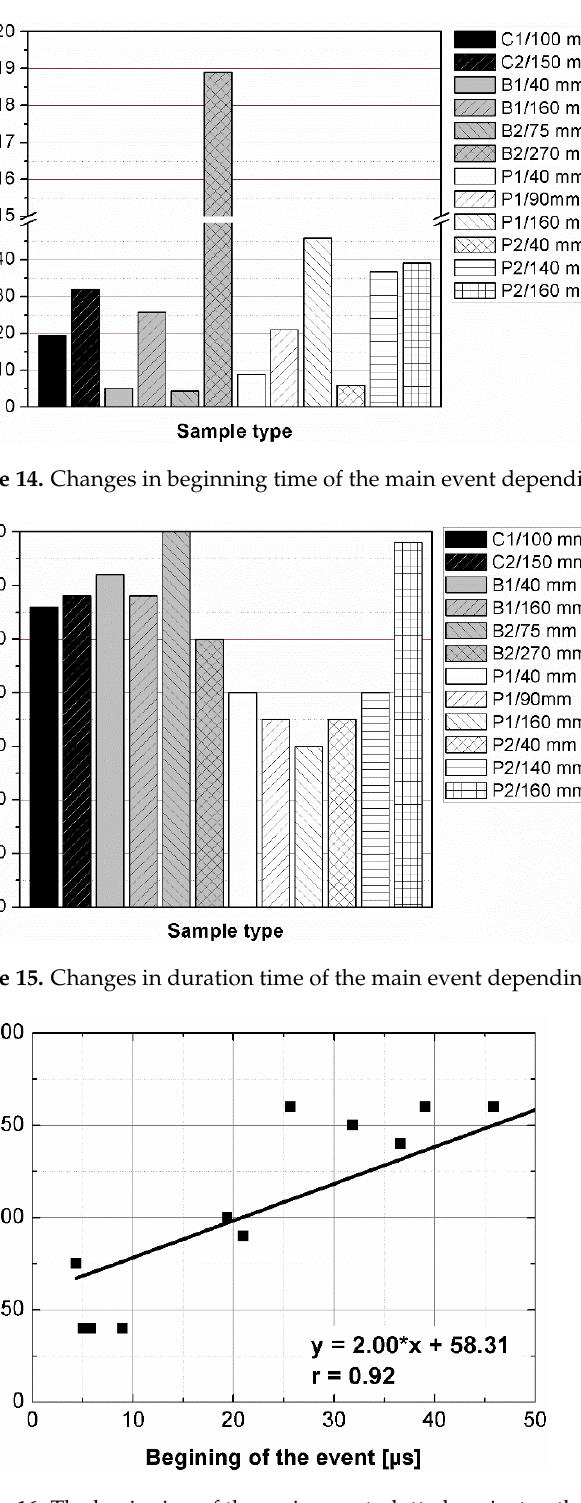
Figure 13. Spectrograms obtained by Fourier synchrosqueezing transform of signals registered after transmission through epoxy concrete samples with different shape and dimensions.